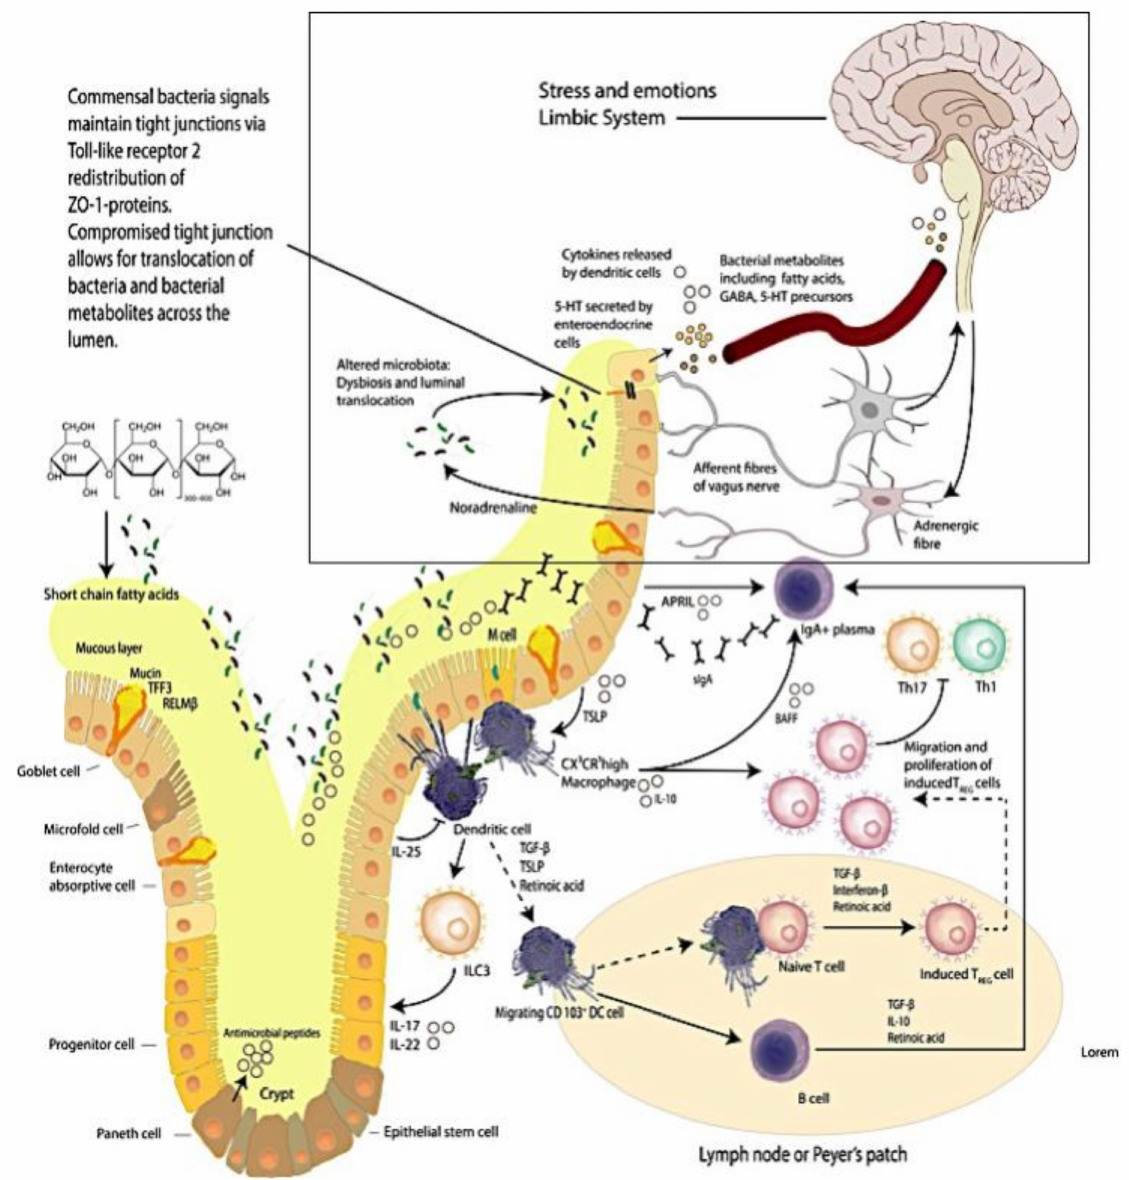
Figure 1. The Brain–Intestinal Microbiome–Intestinal Epithelia–Neuroendocrine-immune–Vagus Nerve–Brain Loop. Mucus production and immune activities delineate the complexity of the intestinal mucosa site. (This figure was adapted from selected reviews